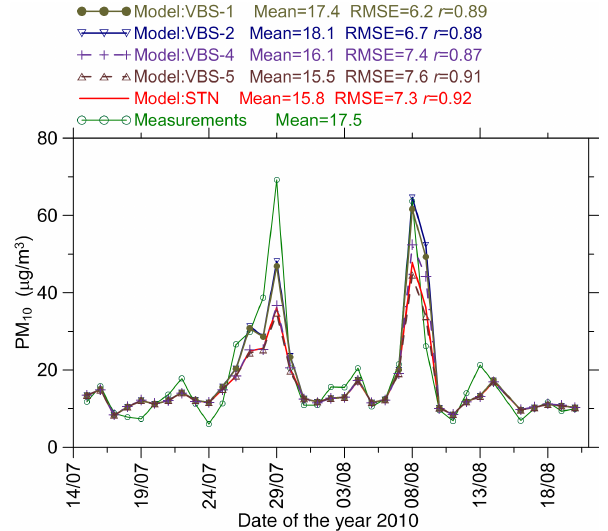
Figure 5. Time series of daily PM 10 concentrations according to different simulation scenarios in comparison with measurements in Kuopio. Note that the time series for the VBS-3 scenario, which is shown in Fig. 4b, is omitted in this figure. Note also that the fire emissions for each scenario were fitted independently to measure- ments in the Moscow region (see the estimates of the emission cor- rection factor, F α , in Table 4 and the respective remark in Sect.